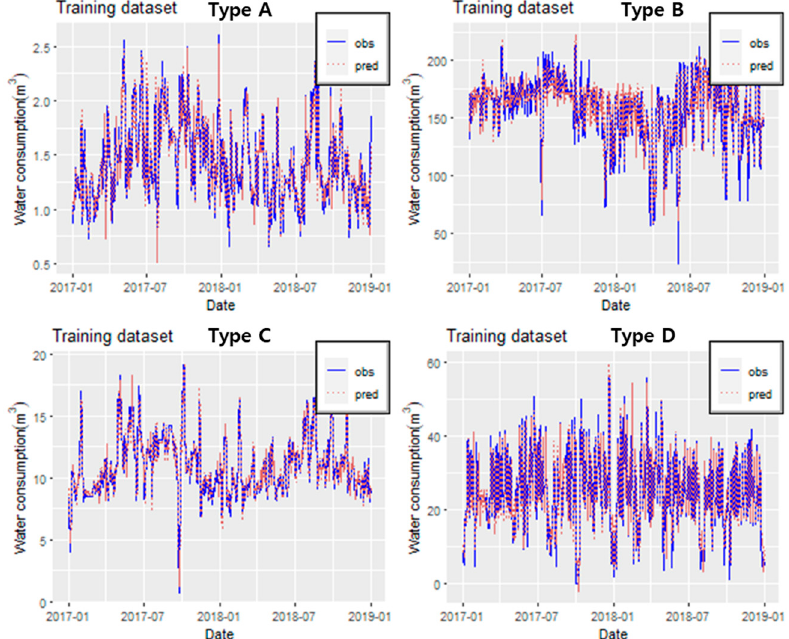
Figure 7. Time series of the predicted and observed values by the ARIMA model (training dataset).